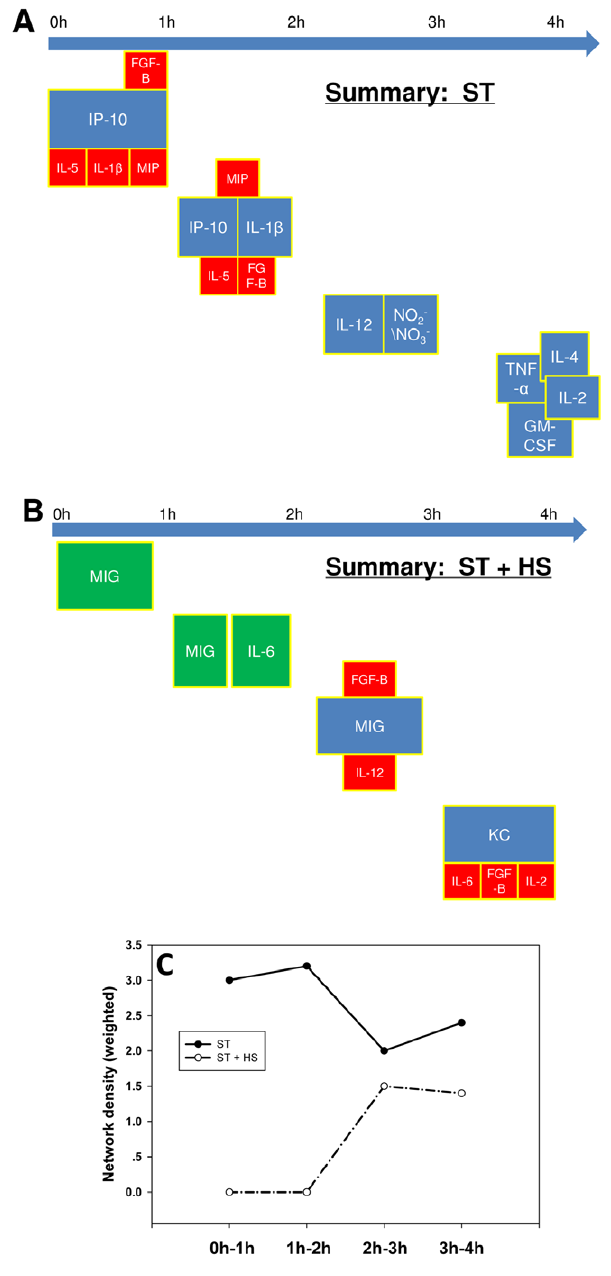
Figure 5. Dynamic Network Analysis summary for ST 6 HS. Mice were subjected to ST 6 HS followed by measurement of cytokines, chemokines, and NO 2 2 /NO 3 2 as described in the Materials and Methods . DyNA was carried out using these data as described in the Materials and Methods. Panel A: DyNA for ST, during each of the following four time frames: 0–1 h, 1–2 h, 2–3 h, and 3–4 h. Panel B: DyNA for ST + HS. In both Panels A and B , the most connected inflammatory mediators (nodes) are depicted in blue, and the inflammatory mediators linked directly to each central node are depicted in red. The mediators depicted in green are statistically significantly different from their own baseline values (p , 0.05), but not correlated with any other mediators. Panel C: Network density plot for ST and ST + HS during each of the four time frames (0–1 h, 1–2 h, 2– 3 h, and 3–4